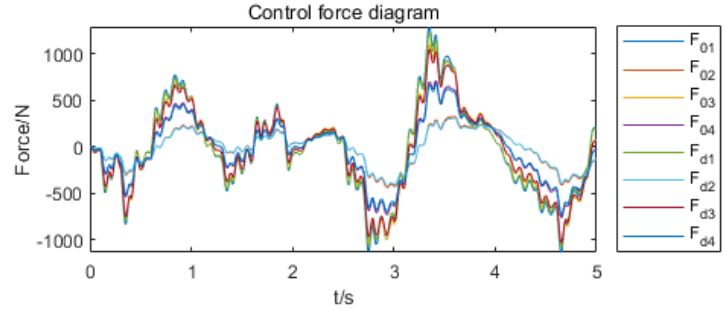
Figure 15. Comparison of the control force of each actuator.